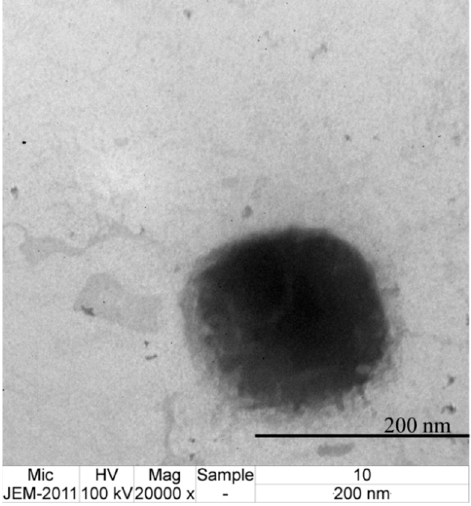
Figure 6. Transmission electron microscopic image of a representative SBO-NLC.